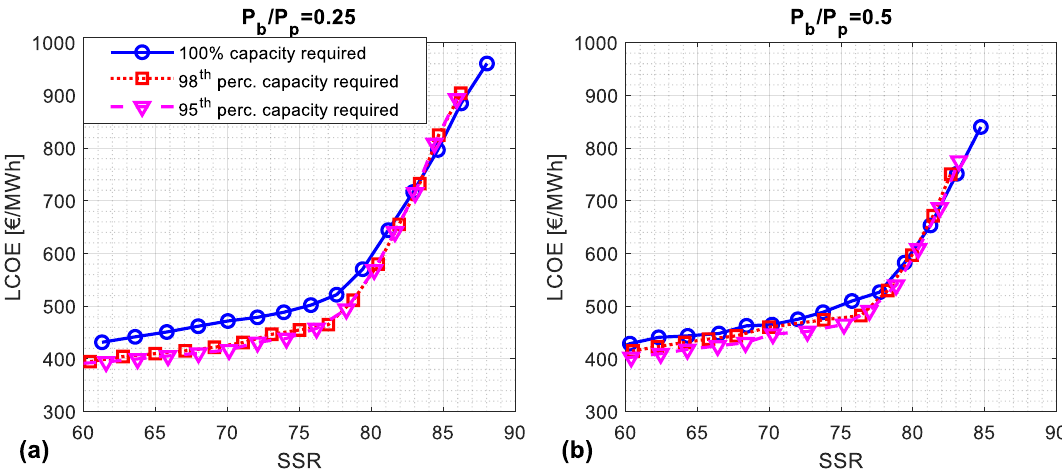
Figure 13. Levelized cost of energy (LCOE) vs. self-sufficiency ratio (SSR) without limitation on the storage capacity and with a reduction to the 98th and 95th percentile of the theoretical requirements for ( a ) P b /P p = 0.25 and ( b ) P b /P p = 0.5.